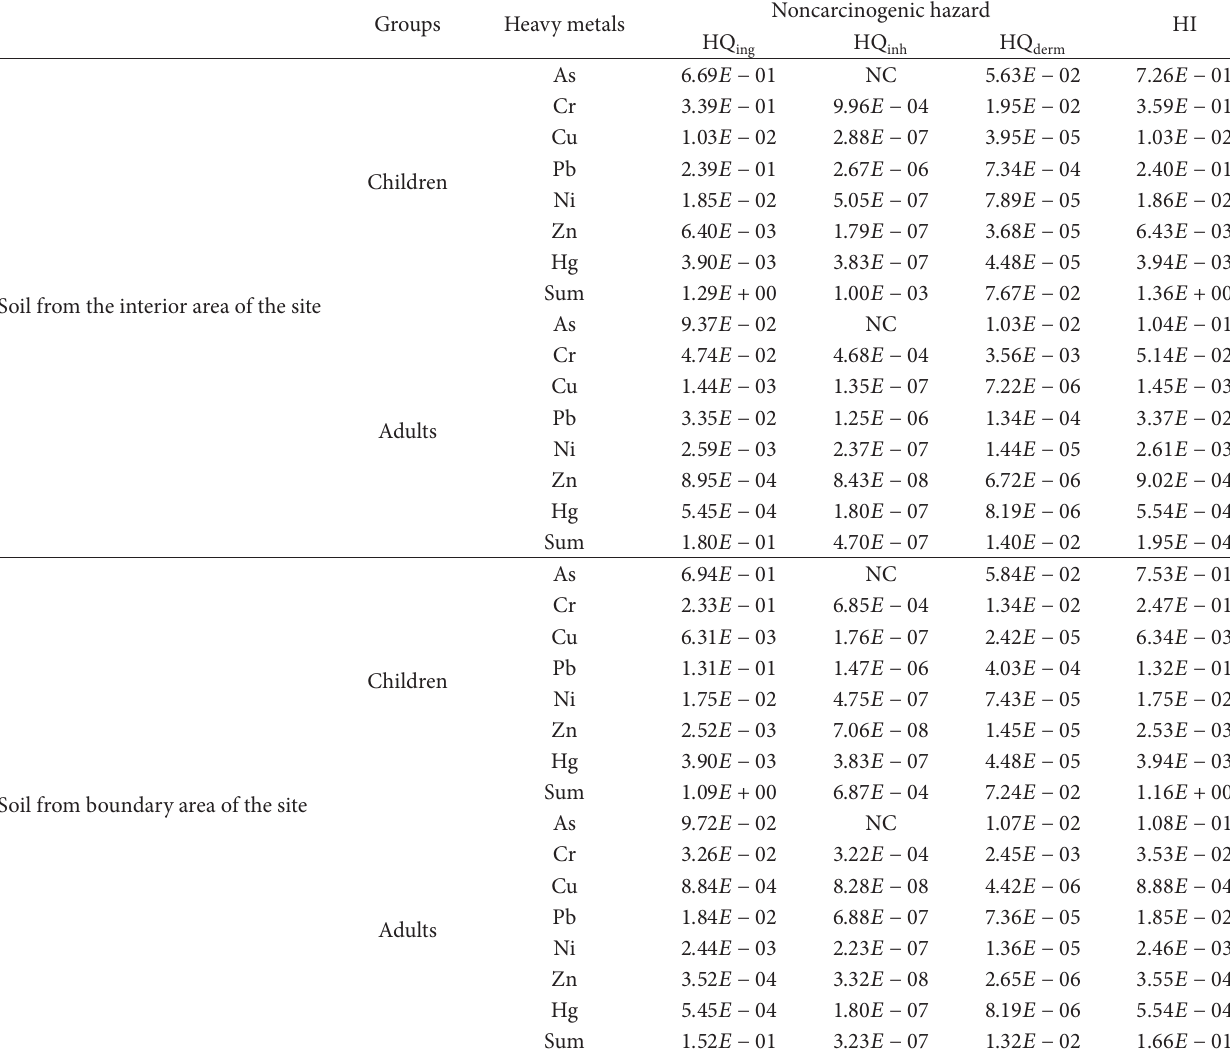
Table 7: Noncarcinogenic hazards of heavy metals corresponding to different exposure pathways.